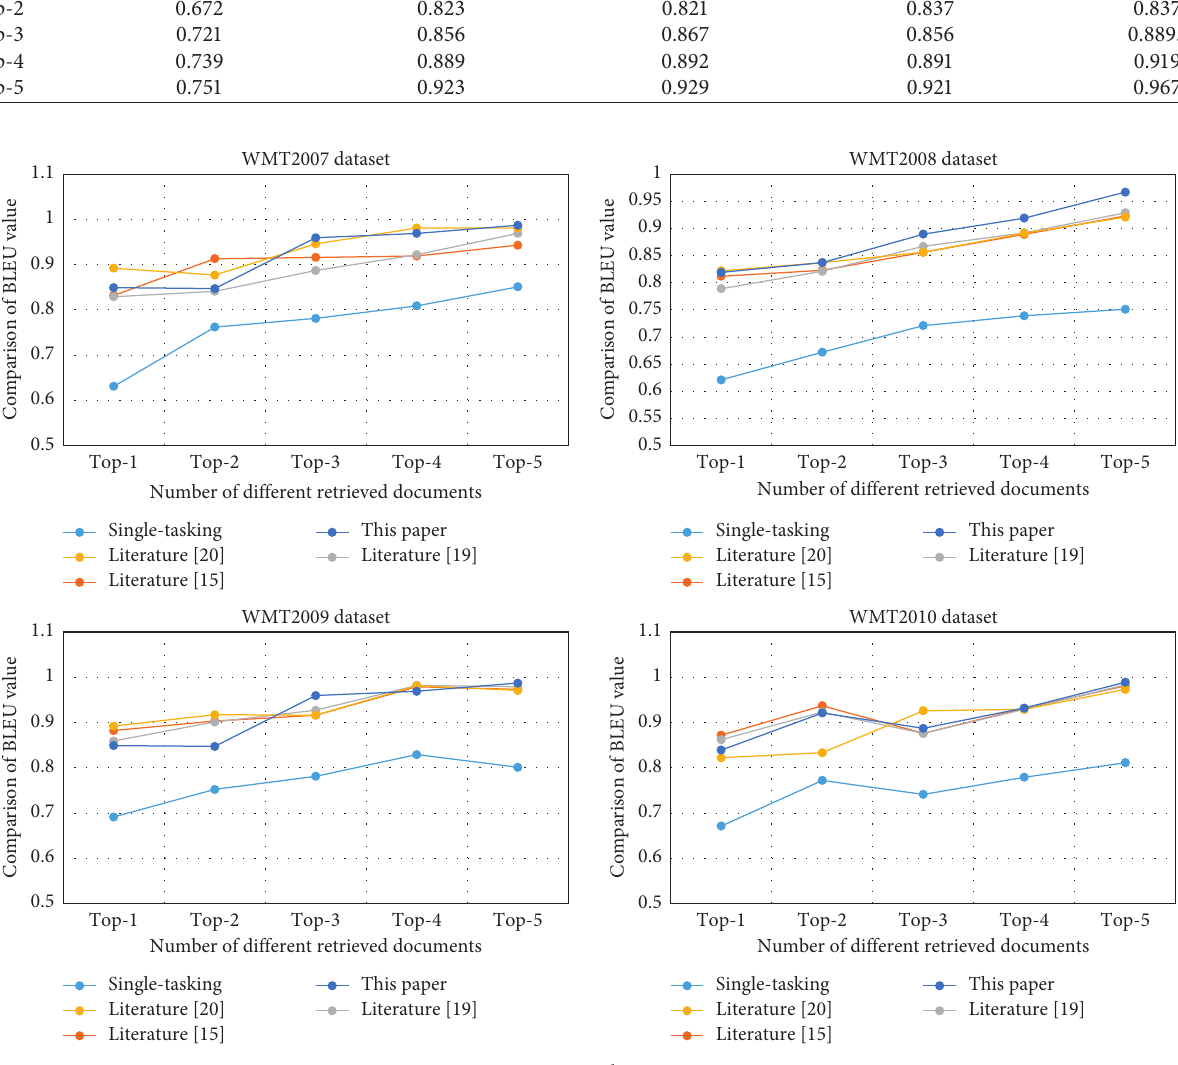
Figure 8: Sentence translation accuracy